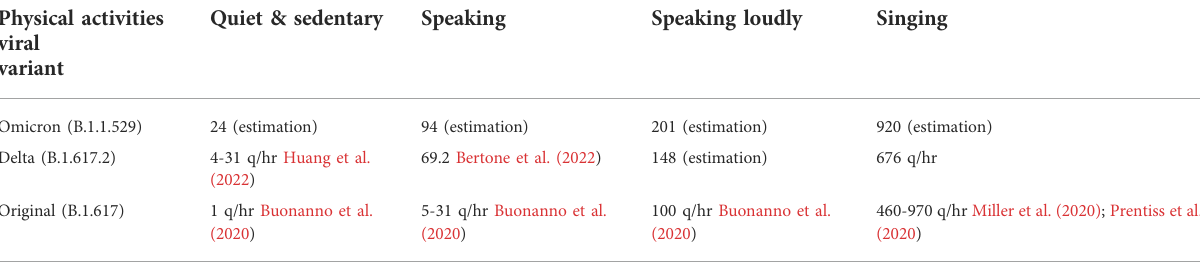
TABLE 1 The quanta emission rates from a primary patient by viral variant and levels of physical